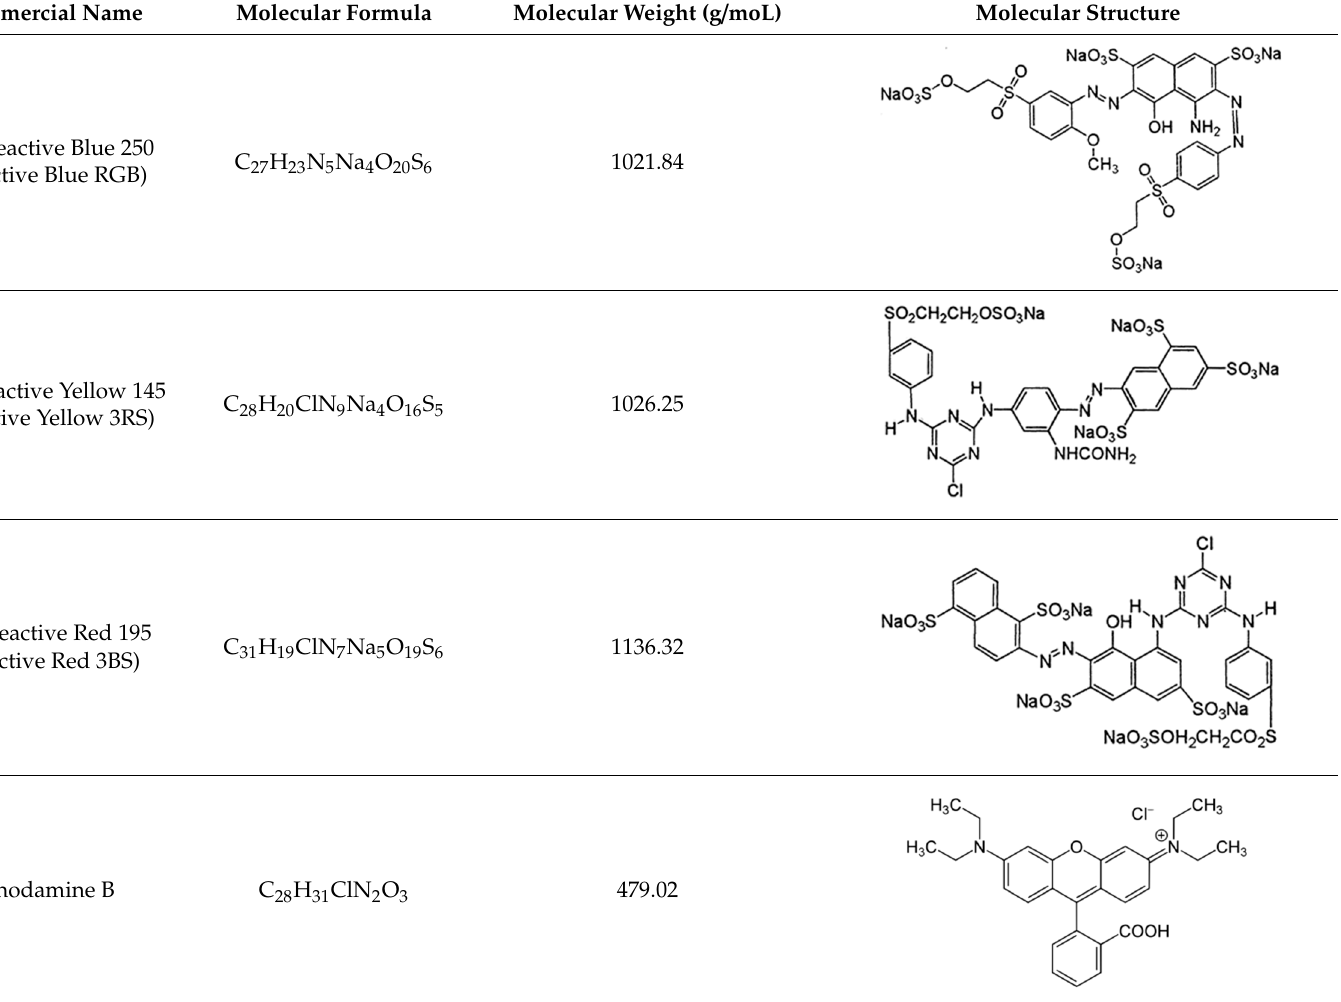
Table 1. Structure of the textile dyes and model dye used for photodegradation assays.